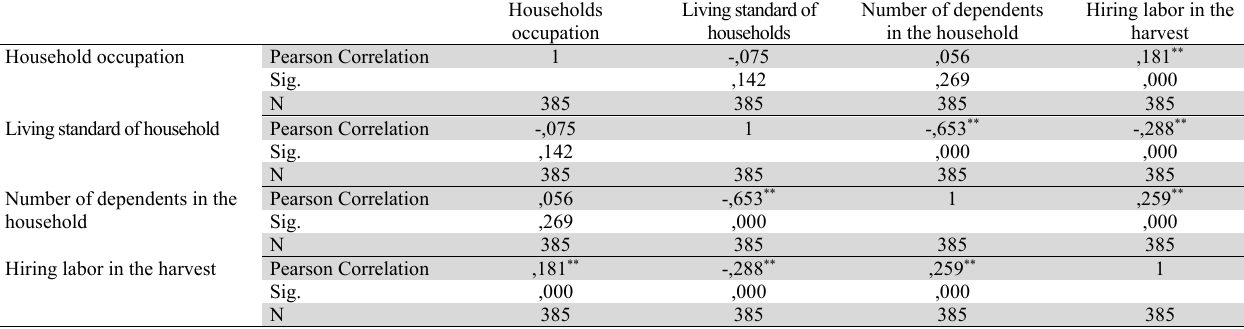
Correlation matrix between household characteristics and hiring